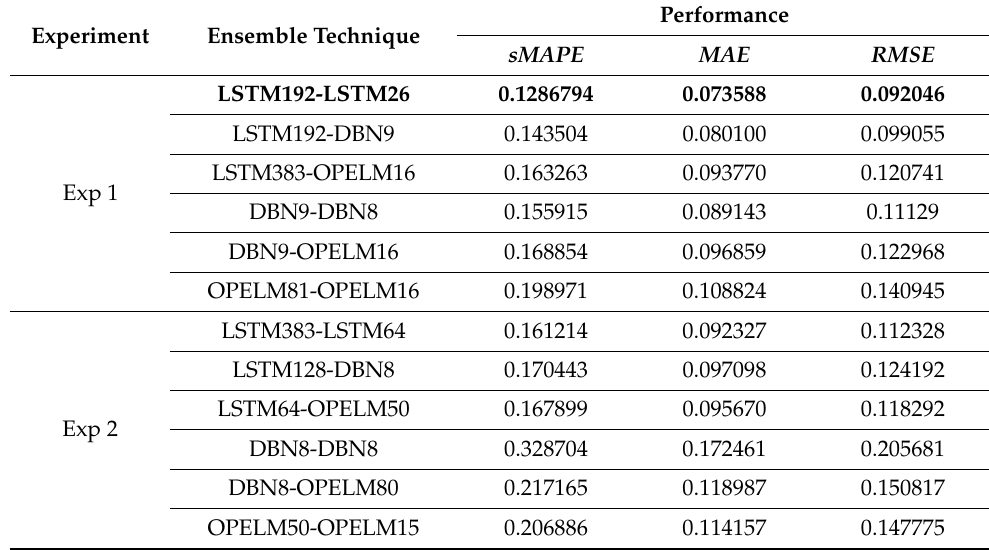
Table 7. Ensemble experiments